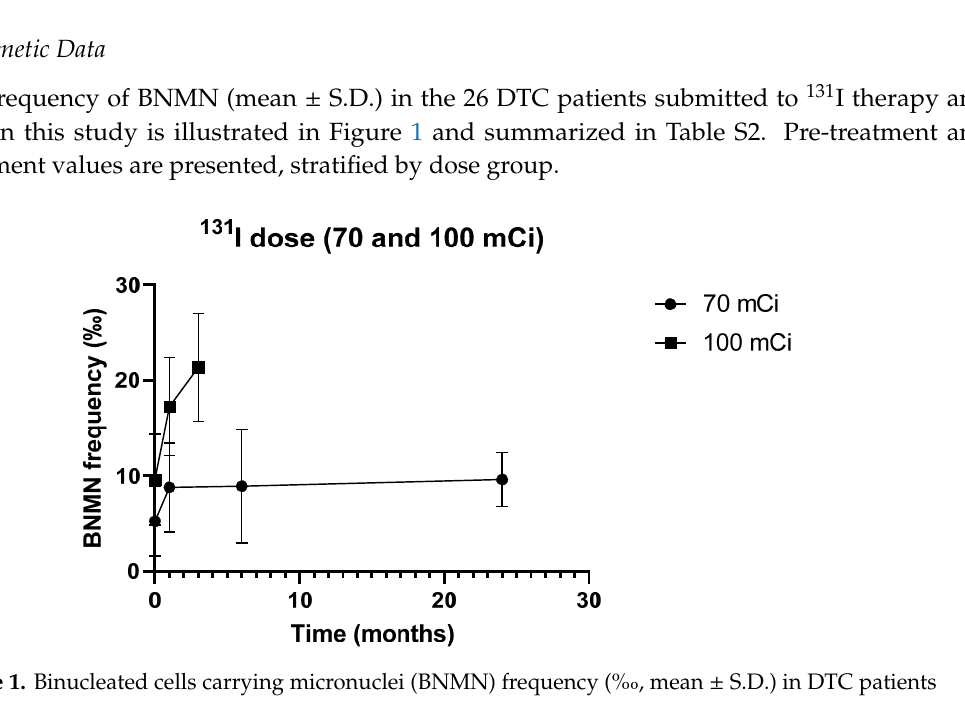
Figure 1. Binucleated cells carrying micronuclei (BNMN) frequency (‰, mean ± S.D.) in DTC